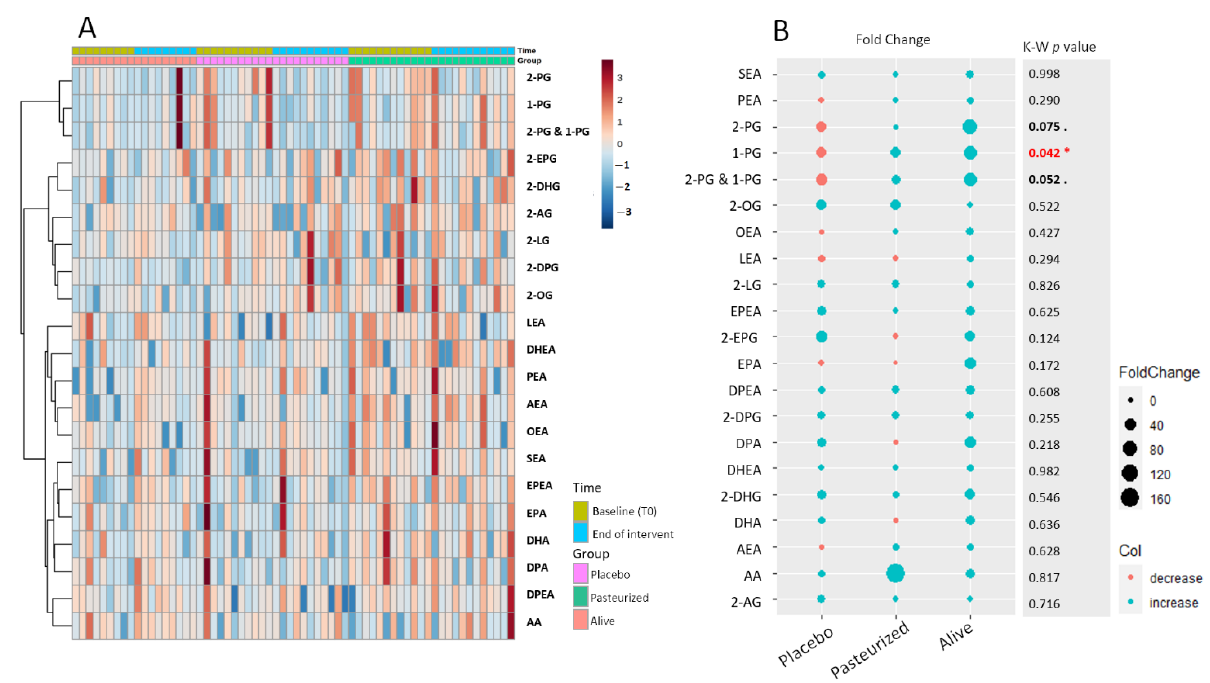
Figure 1. ( A ) Time-series hierarchical cluster analysis. The heat map visualized the levels of eCBome-related mediators according to each time and for each participant. Colored boxes indicate the normalized concentration of the corresponding eCB-related mediator from blue (lowest) to red (highest). Columns correspond to samples and rows to the eCB-related mediators. The algorithm for heatmap clustering was based on the Euclidean distance measure for similarity and Ward clustering algorithm. ( B ) Fold change in eCB-related mediators according to the group expressed in percentage. The size of the dot is proportional to the value of the fold change calculated within each group. The blue dots represent positive fold changes, meaning that the corresponding parameter had increased in average percentage following the treatment according to the baseline value, while the red dots represent negative fold changes, meaning that the corresponding parameter had decreased in average percentage following the treatment. The “K-W p -value” column shows the approximate p -value of the Kruskal–Wallis statistical test applied to the row delta taking into account the 3 groups. * Red writing: p < 0.05; bold writing 0.1 > p -value > 0.05. Placebo group, n = 11; pasteurized bacteria group, n = 12; alive bacteria group, n = 9. Abbreviations: see Table 1.